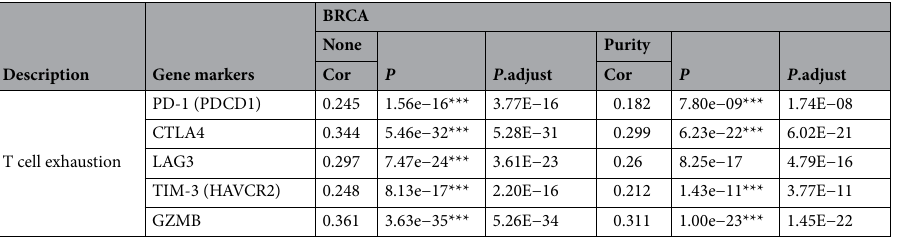
Table 2. Correlation analysis between GSDMC and relate genes and markers of immune cells in TIMER. BRCA breast invasive carcinoma, TAM tumor-correlated macrophage, Tfh follicular helper T cell, Th T helper cell, Treg regulatory T cell. Cor, R value of Spearman’s correlation; None, correlation without adjustment. Purity, correlation adjusted by purity. * P < 0.01 (1e−02); ** P < 0.001 (1e−03); *** P < 0.0001